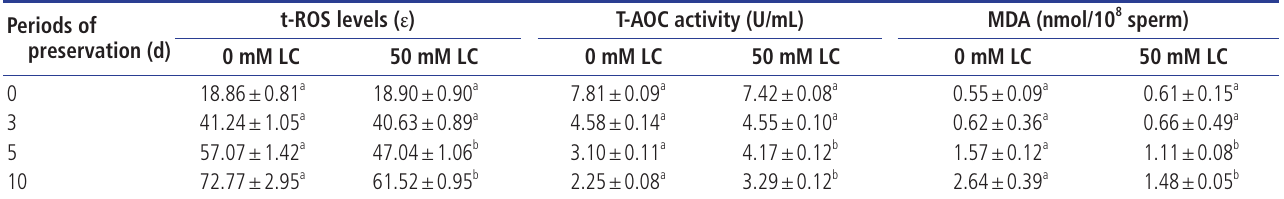
Table 3. Effects of L-carnitine on t-ROS levels, T-AOC activity, and MDA content of boar sperm Periods of preservation (d)